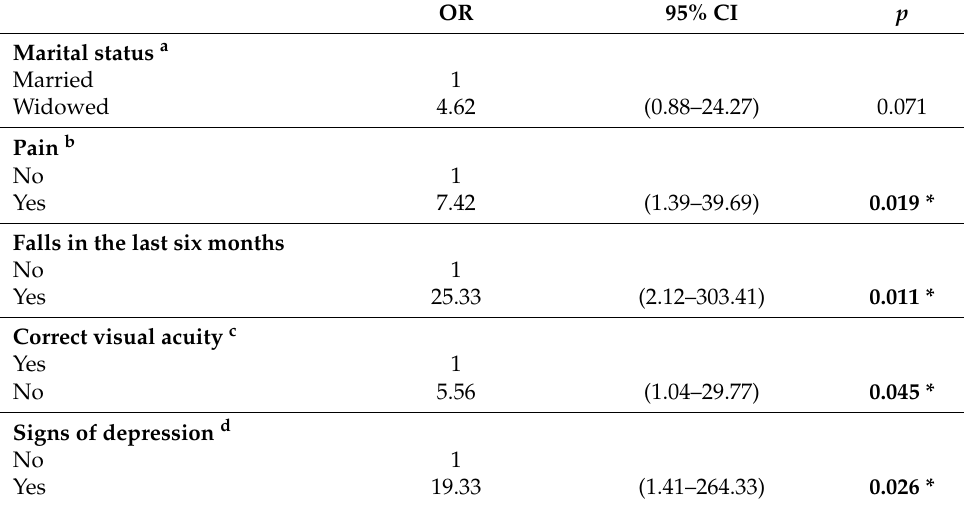
Table 4. Adjusted model of the prevalence of fear of